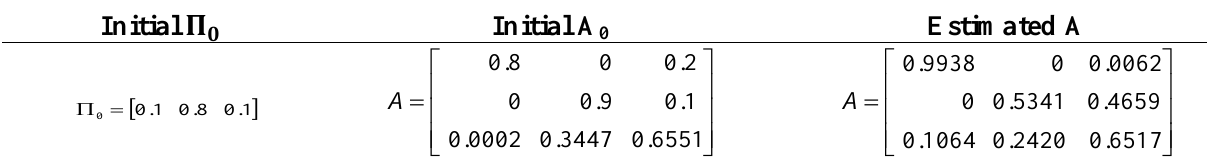
Table 3. Three-state Fritchman model for a dynamic HBC